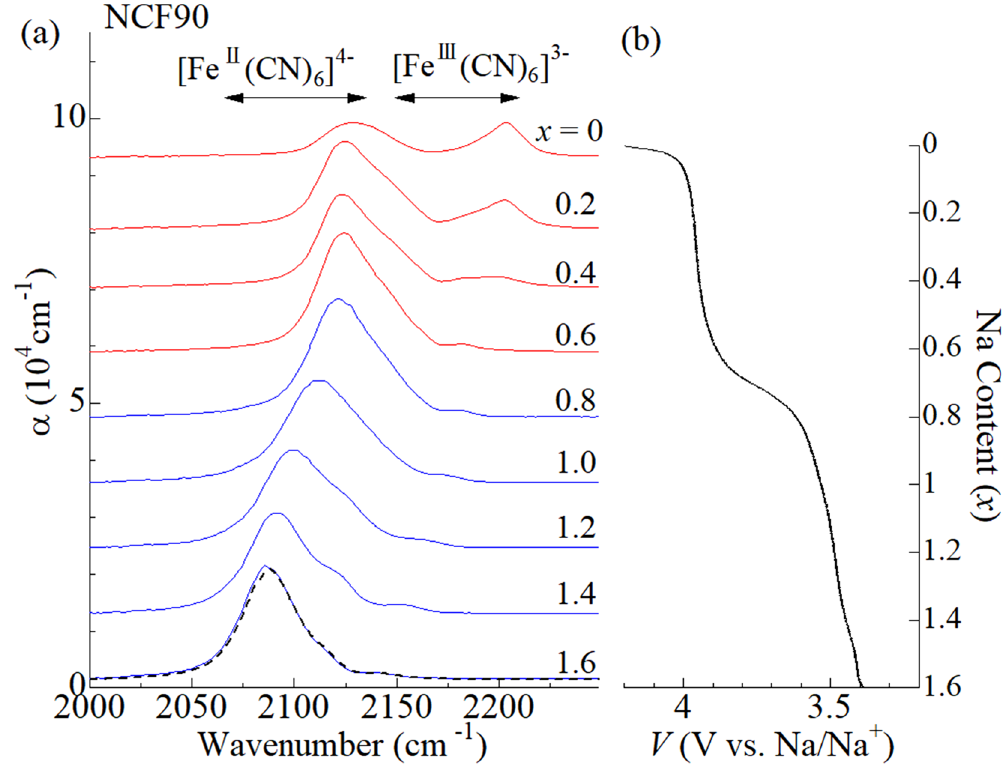
Figure 2. (a) In situ IR spectra of the NCF90 film at 293 K against Na concentration ( x ) in the oxidation process from x = 1.6 to x = 0. Black broken curve at x = 1.6 was obtained after the measurement. α is absorption 1 ln I 0 coefficient; α = d I , where d is the film thickness, I 0 is the incident beam intensity, and I is the transmitted beam intensity, respectively. Spectra are vertically shifted for clarity. The horizontal arrows indicate the empirical region for the CN - stretching modes in [Fe II (CN) 6 ] 4- and [Fe III (CN) 6 ] 3- , respectively. (b) Charge curve of NCF90 film at 293 K against x at 1.6 C. The voltages of the electrochemical cell were scaled to vs. Na/Na +